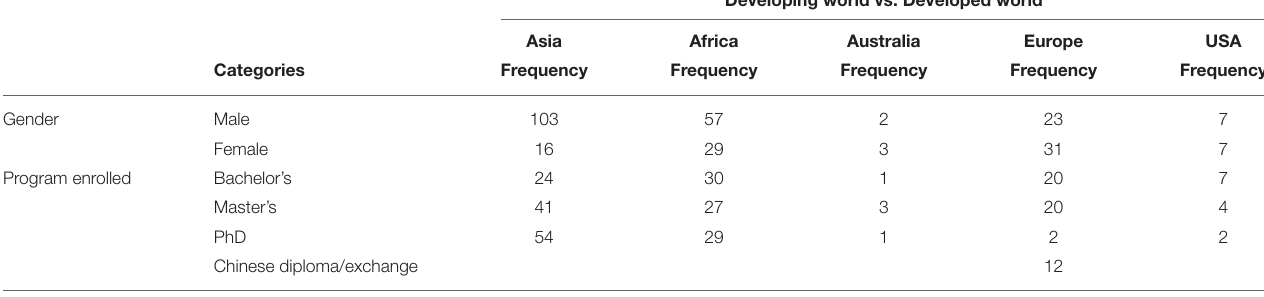
TABLE 2 | Descriptive statistics and